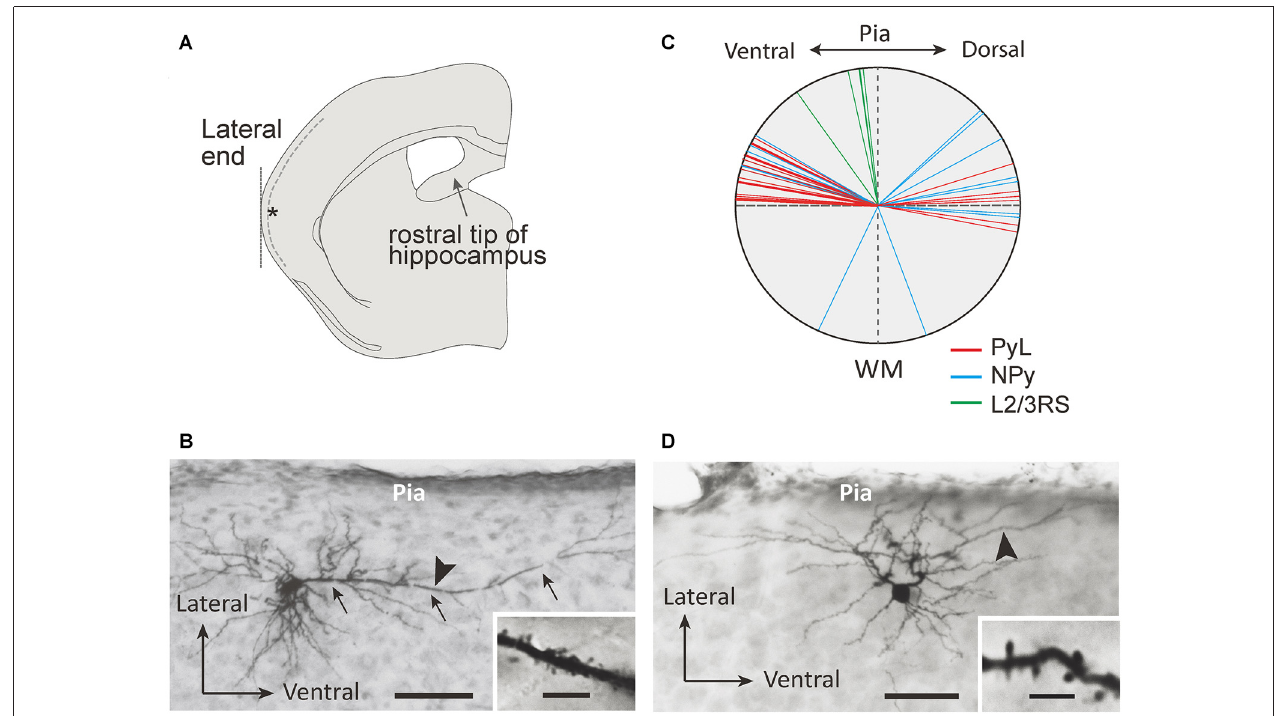
FIGURE 1 | Morphological properties of L2 marginal neurons (L2MNs). (A) A schematic drawing of a coronal slice used for recording. Inclusion of the rostral end of the hippocampus was used as the criterion to select the slice; the target recording site is marked with the asterisk; the dotted line shows the border between L1 and L2. (B,C) Photomicrographs of a L2MN pyramidal-like (PyL; B ) and a non-pyramidal (NPy) (C) neuron, intracellularly stained with biocytin. Arrows in (B) mark the “apical” dendrite. Scale bar = 100 µ m. Insets in (B,C) : high magnification images of the dendritic segments marked by the arrowhead in (B,C) ; the dendrites were covered with spines. Scale bar = 5 µ m. (D) The apical dendrite orientation of PyL (red line; n = 22), NPy (blue line; n = 14) and L2/3RS (green line; n = 5)